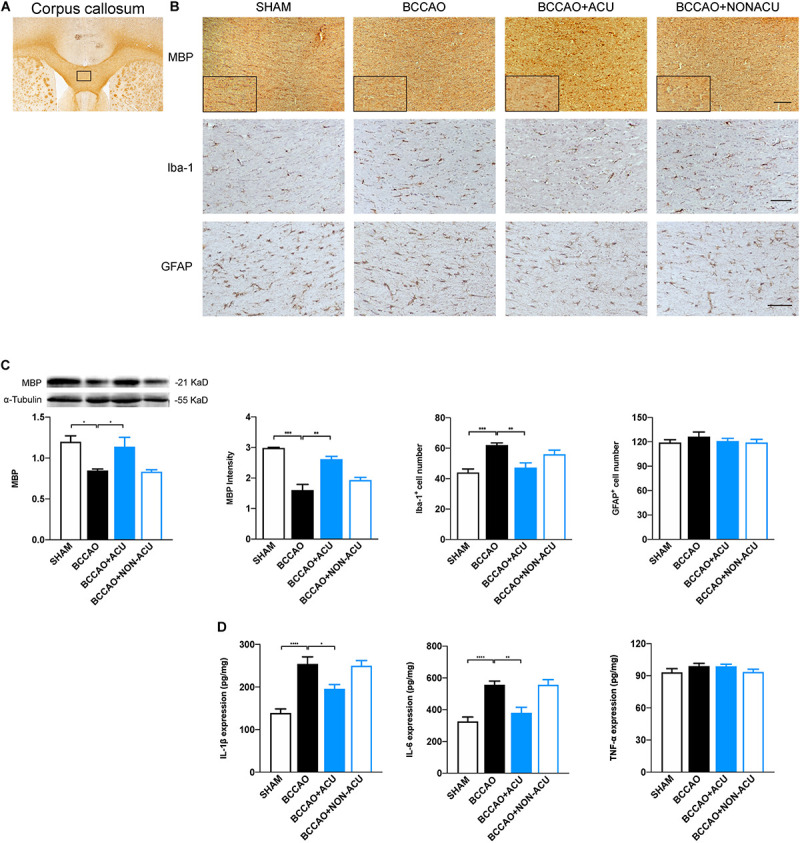
Acupuncture Attenuates Loss of Myelin Sheath and Microglia Activation in BCCAO-Induced CCH Rats. (A) ROI of corpus callosum for immunohistochemistry (black rectangular box). (B) Representative and magnification (black rectangular boxes) immunostaining of MBP, Iba-1+, and GFAP+ glia in four groups. (C) Quantification of protein level of MBP, calculations of MBP+ area, Iba-1+ cell number, and GFAP+ cell number. (D) Quantification of neuroinflammatory markers including IL-1β, IL-6, and TNF-α in white matter of SHAM, BCCAO, BCCAO + ACU and BCCAO + NON-ACU groups. Scale bar: 50 μm, data are presented as mean ± SEM (n = 6 per group). ∗p < 0.05, ∗∗p < 0.01, ∗∗∗p < 0.001, ****p < 0.0001. MBP, myelin basic protein; Iba-1, ionized calcium binding adapter molecule 1; GFAP, glial fibrillary acidic protein; SHAM, SHAM-operated group; BCCAO, BCCAO-operated group; BCCAO + ACU, BCCAO-operated + acupuncture at GV20 and ST36 group; BCCAO + NON-ACU, BCCAO-operated + acupuncture at non-acupoints group.